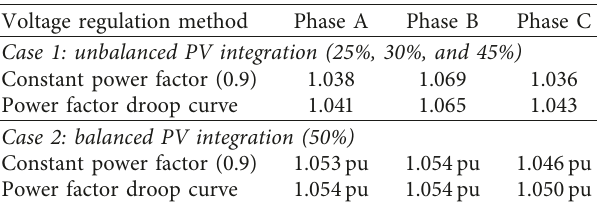
Table 2: Voltage regulation performance with different cases. Voltage regulation method Phase A